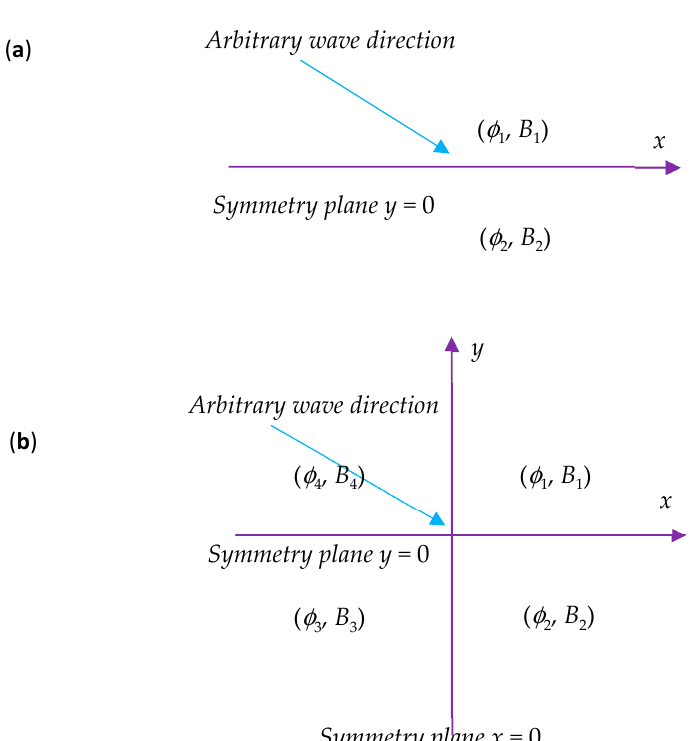
Figure 4. Partitions of the computation domain ( a ) when the body has unique symmetry and ( b ) when the body has two symmetries.